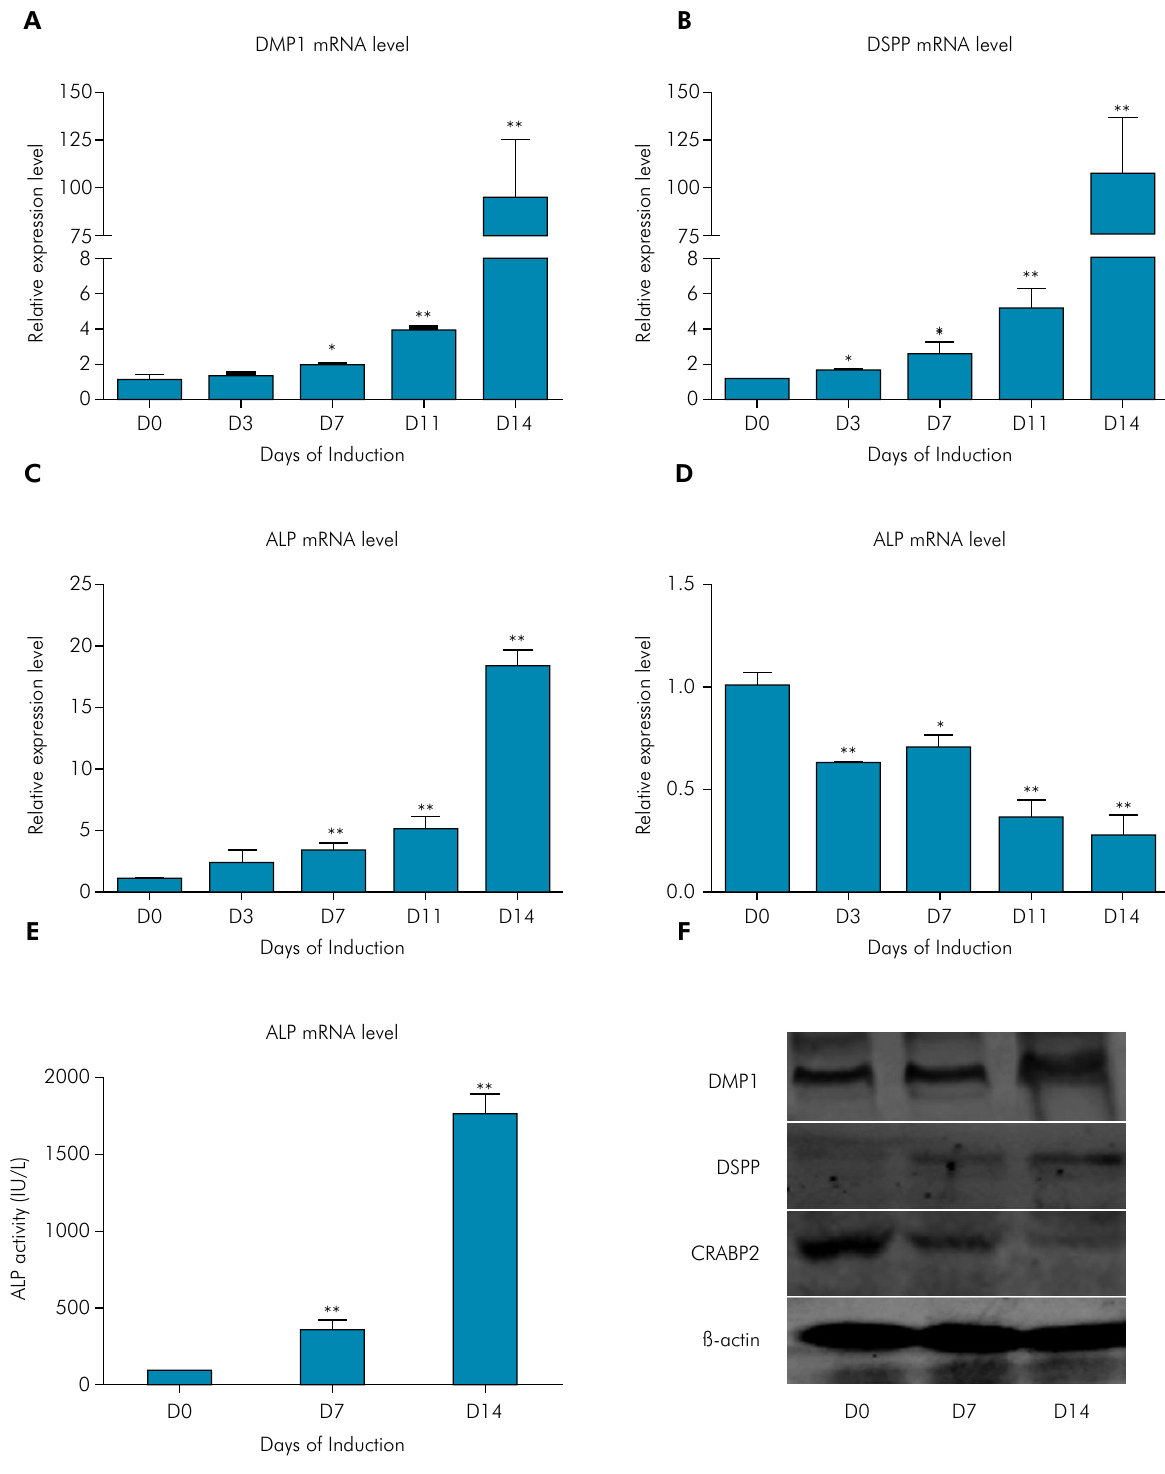
Figure 2. Expression of CRABP2 during odontoblastic differentiation of hDPSCs. A, B and C: The mRNA level of DMP1, DSPP and ALP, respectively, was upregulated during the induction. D: The mRNA level of CRABP2 was downregulated. E: The ALP activity was increased during the same process. F: Western blotting results of DMP1, DSPP and CRABP2 during the induction, which exhibited the same trend as mRNA. The data represent the mean ± SD of at least 3 independent